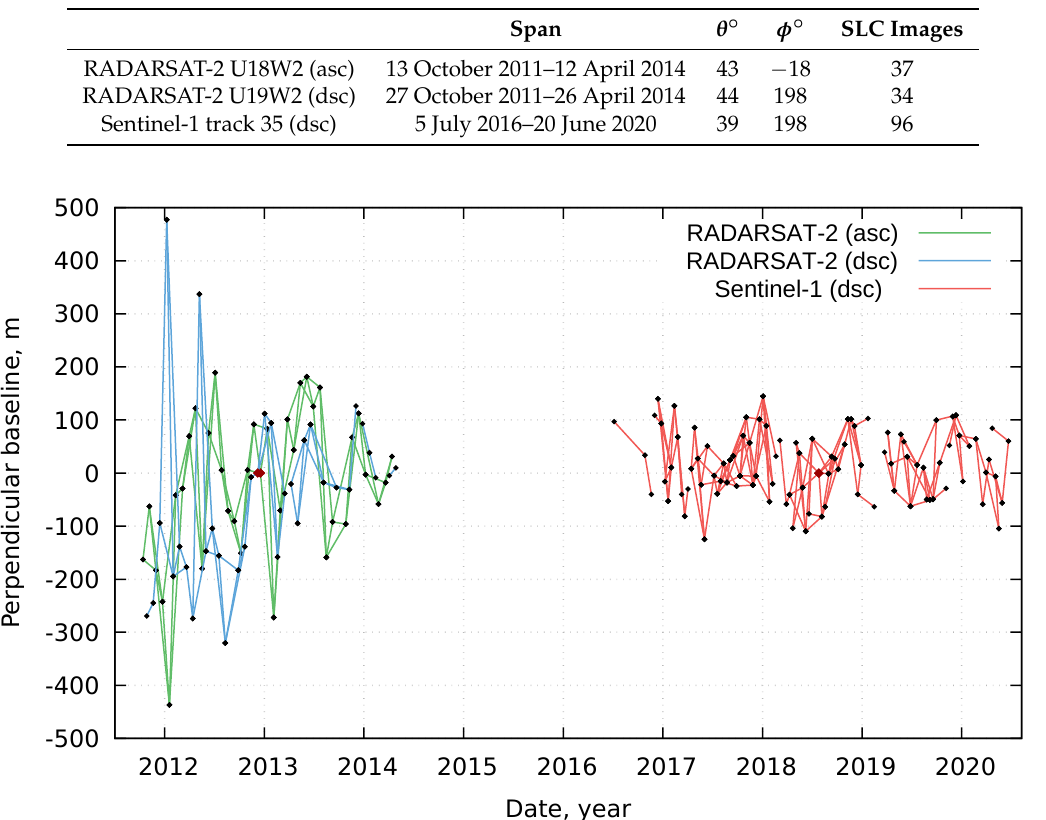
Figure 2. Spatial and temporal baselines of RADARSAT-2 and Sentinel-1 interferograms used in this